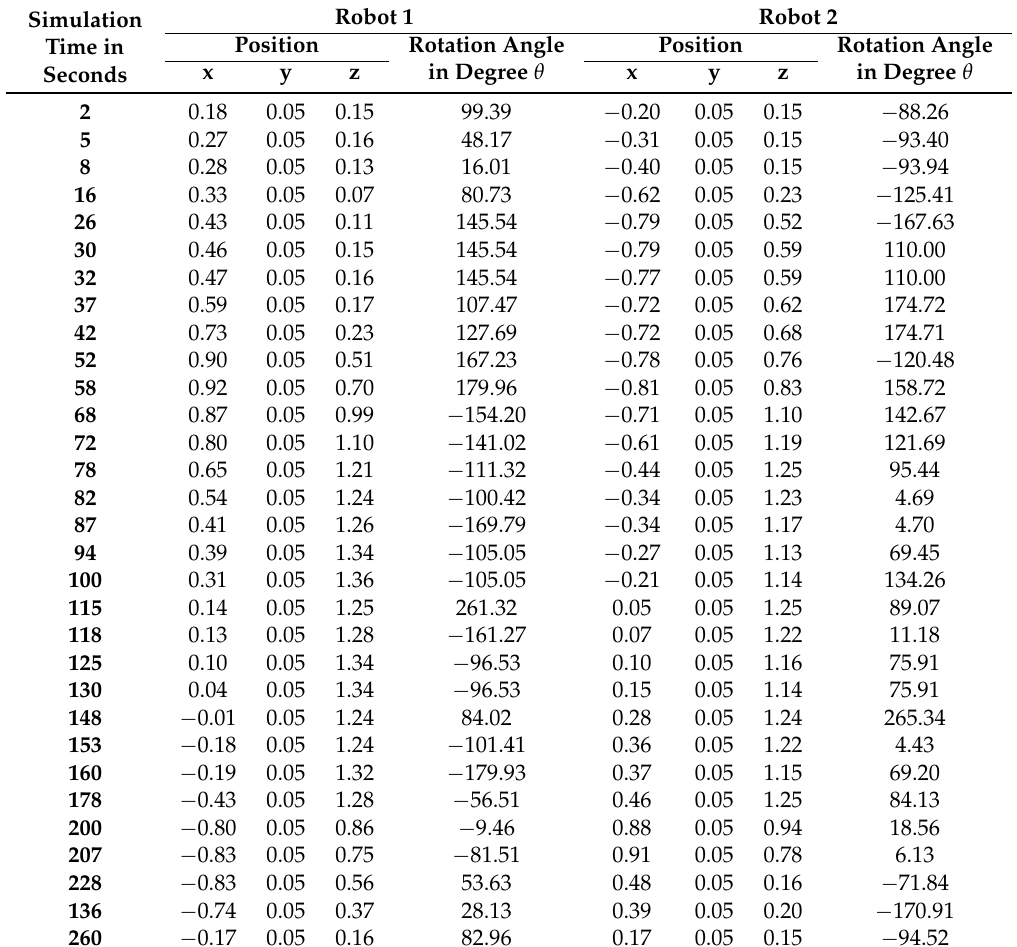
Table 6. The position and orientation of both robots at different simulation